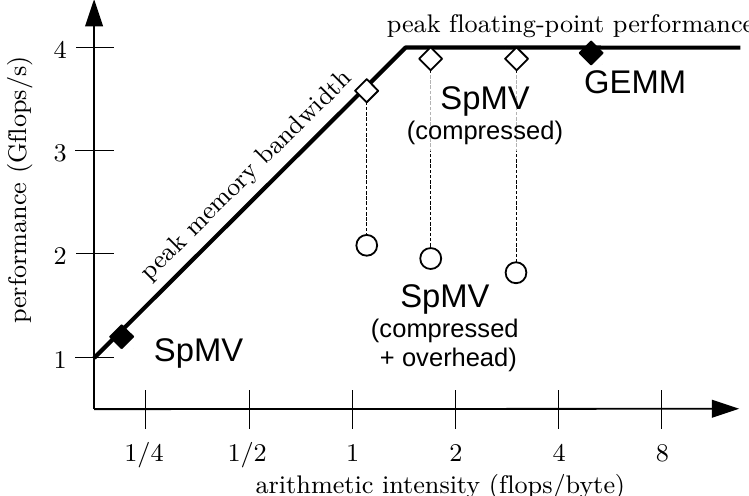
Figure 1. Naive roofline model showing achievable performance vs. the arithmetic intensity. Some computations, e.g., dense matrix-matrix multiplication (GEMM), perform many flops per byte fetched or written to memory, such that their execution speed is bounded by the peak floating point performance. Others, such as sparse matrix-vector multiplication (SpMV), require many bytes to be fetched from memory for each flop, and are therefore memory-bound (filled diamonds). Data compression methods for memory-bound computations can reduce the amount of data to be read or written, and therefore increase the arithmetic intensity. Different compression schemes can achieve different compression factors (empty diamonds on top) and thus different arithmetic intensities. The computational overhead of compression and decompression can, however, reduce the performance gain (empty circles bottom), depending on the complexity of the compression method